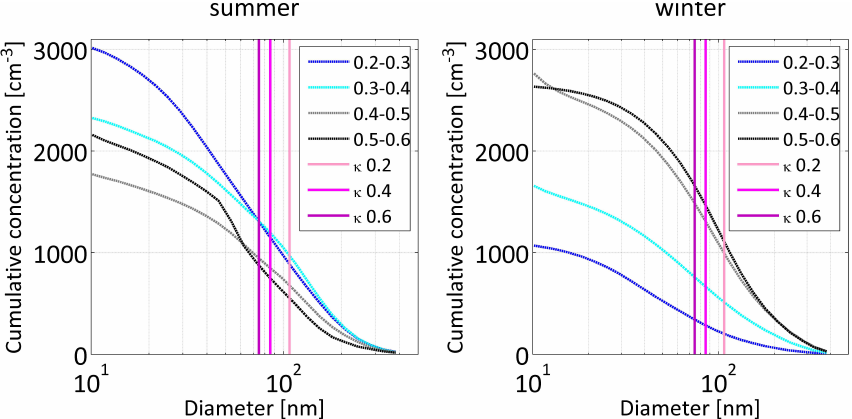
Fig. 5. Selected cumulative number size distribution measured during summer (left) and winter (right) when the total aerosol κ value ranged from 0.2 to 0.3 (blue dashed line), from 0.3 to 0.4 (light blue dashed line), from 0.4 to 0.5 (grey dashed line) and from 0.5 to 0.6 (black dashed line). The horizontal lines depicted mark the corresponding CCN activation diameter for κ values of 0.2, 0.4 and 0.6 (assuming SS of